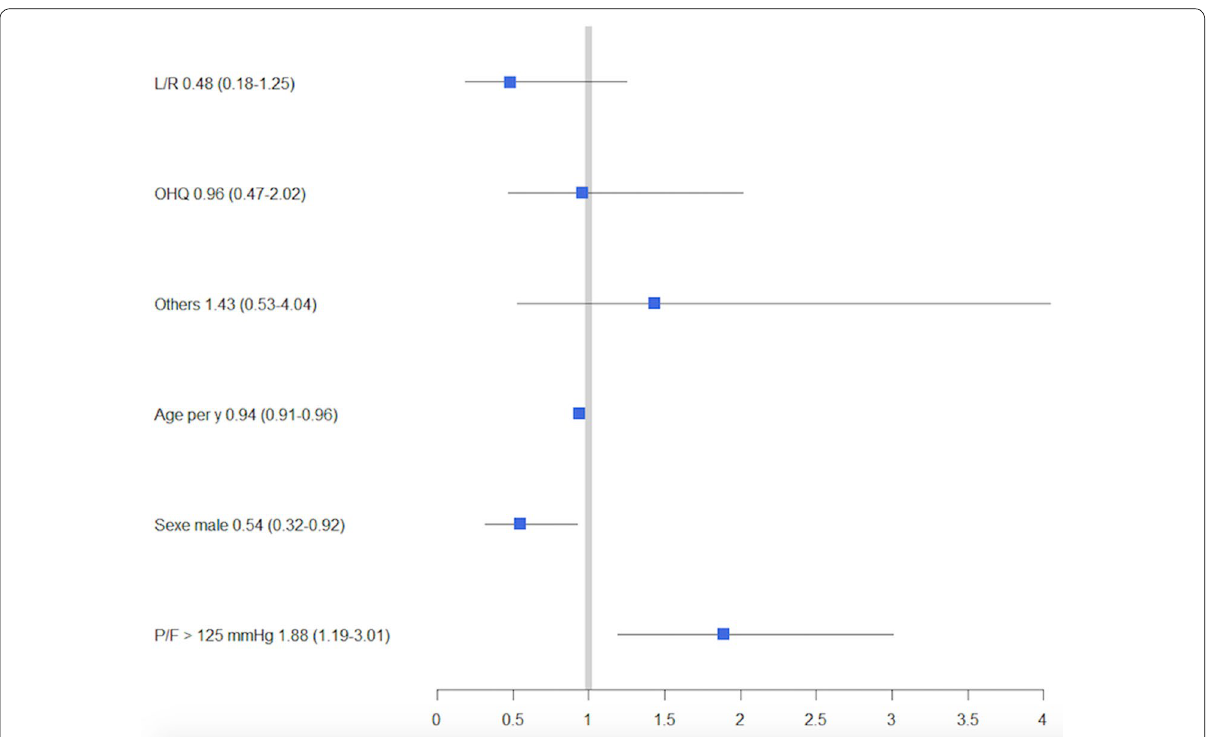
Fig. 1 Forest plot of antiviral strategies effect on being alive and extubated at day 28 after adjustment on age, sex, Charlson Comorbidity Index, plateau pressure and P/F ratio. Standard of care served as reference. ORs (CI95%) are indicated after each variable and were obtained through a generalized linear mixed model with center as random effect ( N 412). L/R lopinavir/ritonavir, OHQ hydroxychloroquine, P/F PaO 2 /FiO =